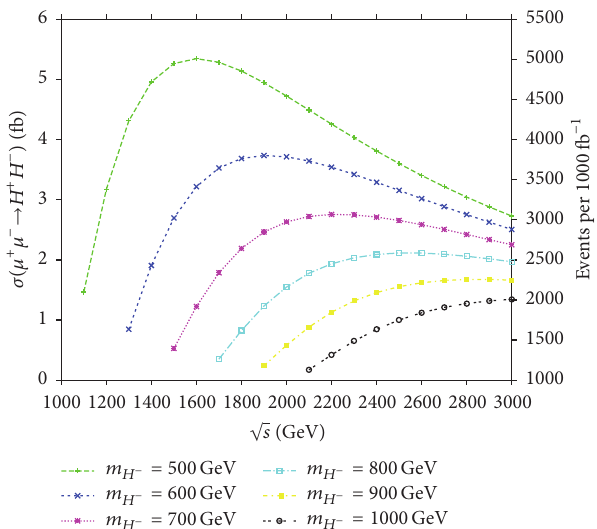
Table 1: Total cross section (in fb) of double charged Higgs at 𝑒 + 𝑒 −